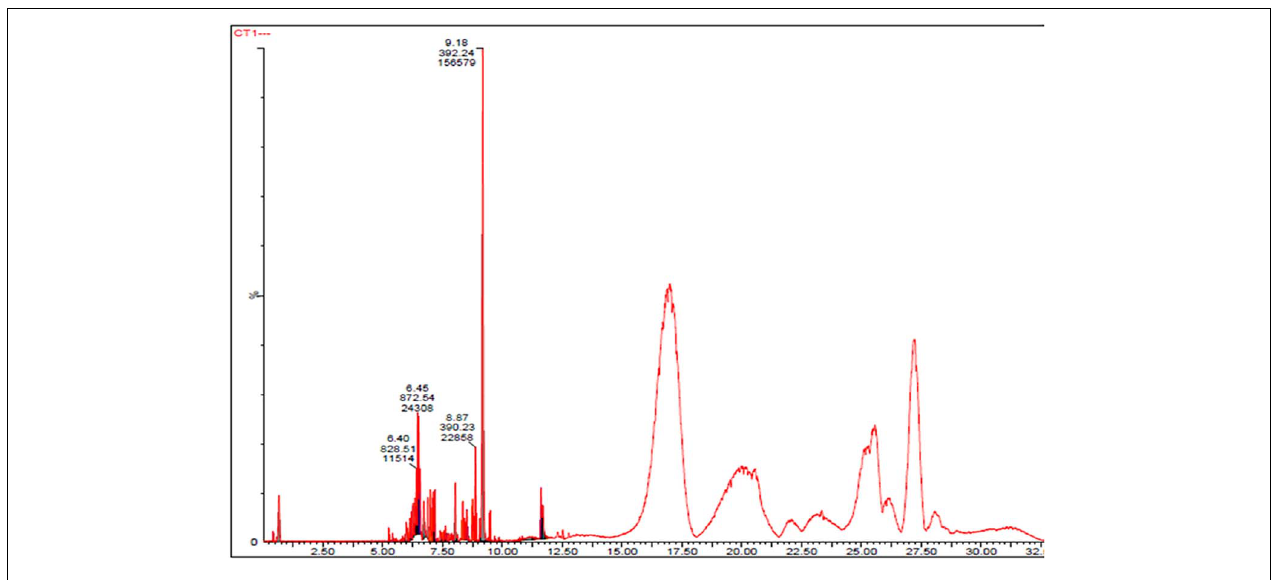
FIGURE 7 | Ultra-high-performance liquid chromatography chromatograms of CPEF04 culture filtrate. TABLE 2 | Determination of bioactive extrolites in the culture filtrate dried powder (CFDP) of Talaromyces sp. CPEF04 by liquid chromatography–electrospray ionization–mass spectrometry (positive ion mode). Analyte